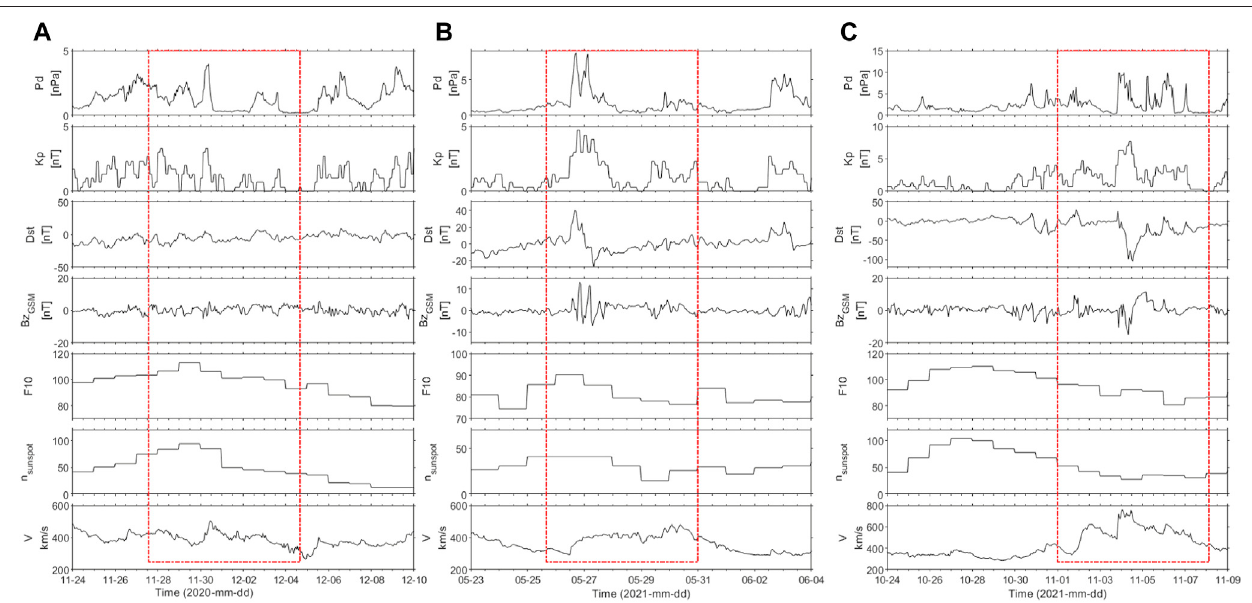
FIGURE 2 | The space weather index for these three typical events (A) for SPE in November 2020, (B) for SPE in May 2021, and (C) for geomagnetic storm in November 2021.